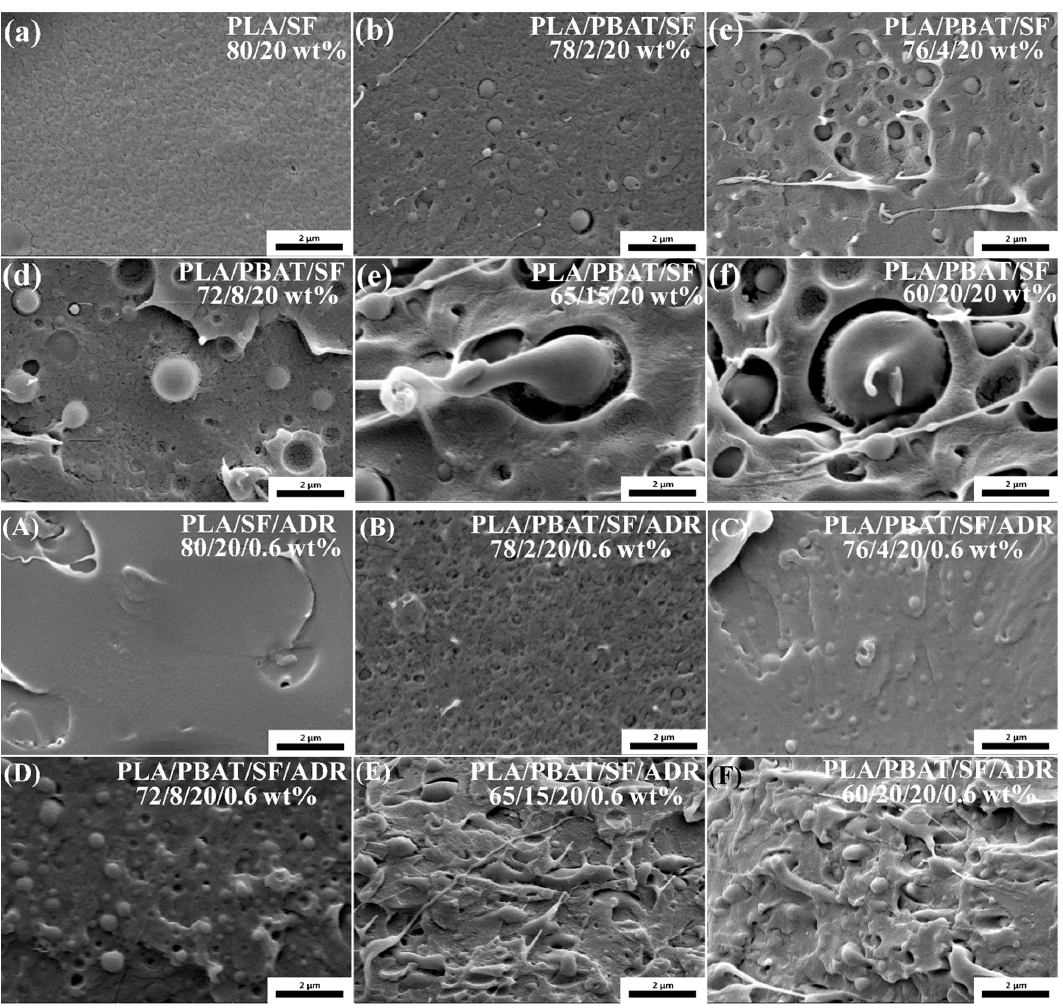
Figure 3. High magnification scanning electron microscope (SEM) micrographs of composites: PLA/SF composites ( a ); PLA/PBAT/SF composites ( b–f ); PLA/SF/ADR composites ( A ); PLA/PBAT/SF/ADR composites ( B–F ). 40,000× magnification.